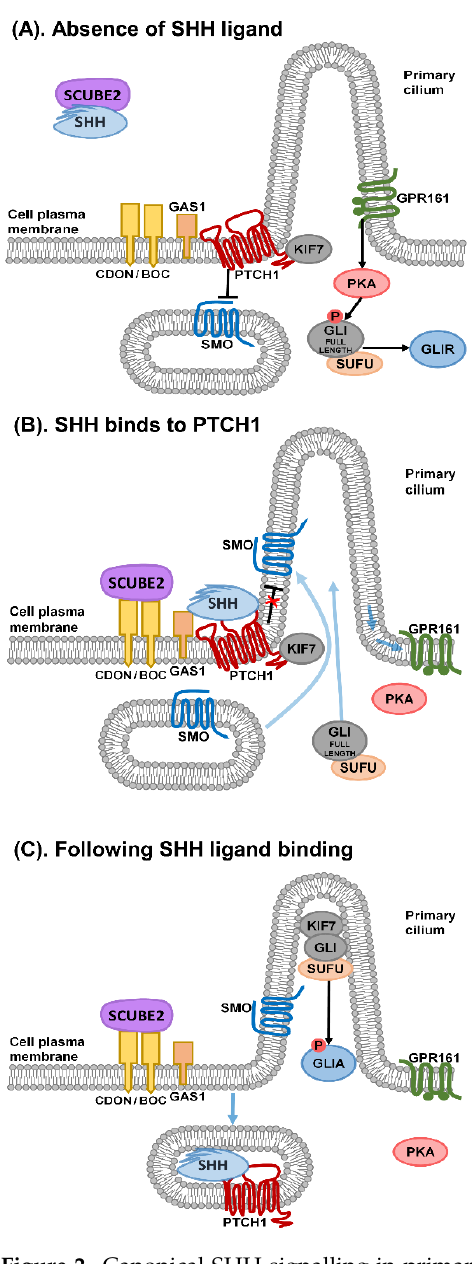
Figure 2. Canonical SHH signalling in primary cilia. ( A ). In the absence of SHH, PTCH1 at the base of the cilium blocks SMO from entry into the cilium. GPR161 activates PKA (protein kinase A), which in turn phosphorylates full-length GLI transcription factors. As a result, full-length GLI becomes cleaved by the proteasome at the base of the cilium to form GLIR (repressor form of GLI). ( B ). CDON/BOC and GAS1 are required for SHH signalling and the proposed role for these co receptors is outlined in [6]. On arrival at the target cell, the SCUBE2–SHH complex is bound by co receptors CDON/BOC, SHH is passed to GAS1 then to its receptor PTCH1. Binding of SHH to PTCH1 causes activation of SMO, resulting in the removal of GPR161 and reduction of PKA activity. Full length GLI is no longer cleaved to form GLIR. ( C ). When SHH binds to its receptor PTCH1, PTCH1 is endocytosed, releasing the inhibition on SMO. SMO accumulates in the cilium. A complex of SUFU, KIF7 and GLI is transported to the top of the cilium where the full length GLI is phosphorylated and converted to GLIA (activator form of GLI) (modified after [12,16,17]). Upon ligand binding, the SHH–PTCH1 complex moves from the primary cilia to the plasma membrane, undergoes endocytosis and is degraded in lysosomes. LDL-related protein 2 (LRP2) functions in the internalising and trafficking of various ligands after re- ceptor binding, including the SHH–PTCH1 complex, and it is necessary for the patterning of the rostral ventral midline in mouse diencephalon [18]. The absence of PTCH1 in the ciliary membrane leads to activation of SMO, which forms a complex with kinesin-like protein KIF3a, after various modifications, and is trans- located to the cilium. SMO can function outside the cilia but enrichment of SMO in the ciliary membrane appears necessary for its optimal function because a mouse mutant where SMO was not enriched in the cilia showed facial and skeletal defects similar (but less severe) to those in mice with complete loss of SMO function [19]. There is a negative feedback loop involving PTCH1, which can modulate HH signalling. HH activates PTCH1 and leads to de-repression of SMO, leading to an increase in PTCH1 and reduction in abundance of HH ligands [20]. The binding of PTCH1 by SHH releases the repression